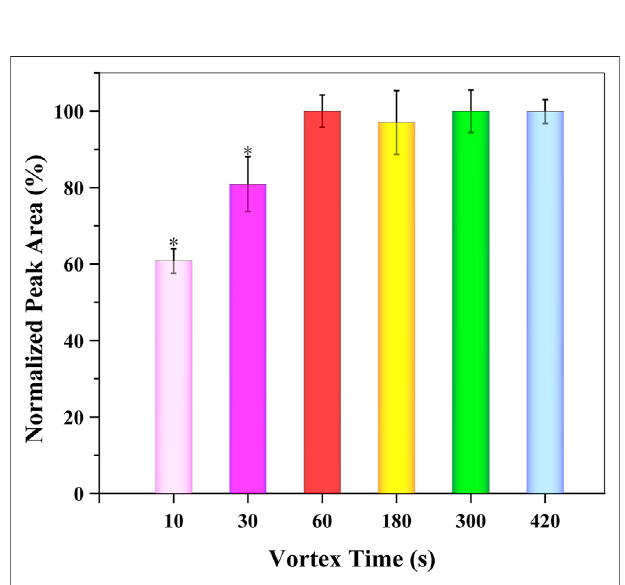
FIGURE 5 | Effect of vortex time on extraction ef fi ciency ( n (cid:2) 3; * p < 0.05).